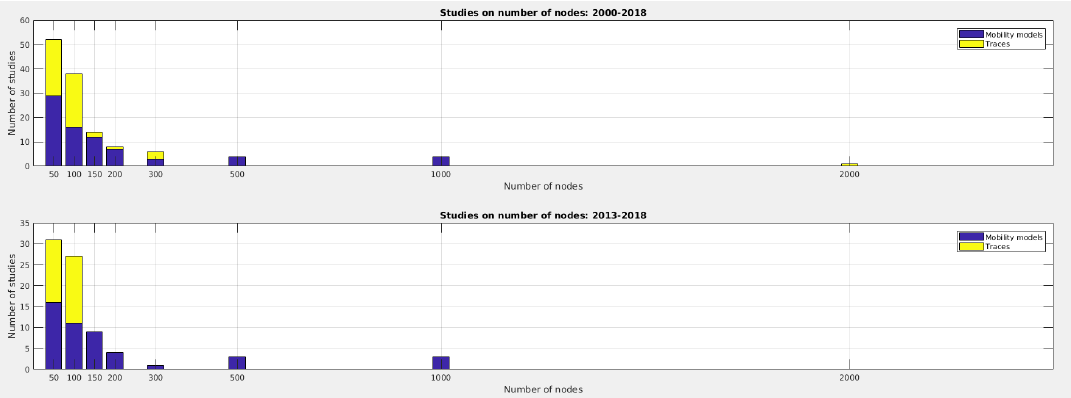
Figure 5. Frequently used network size in the studies. Very large outliers are not shown for better